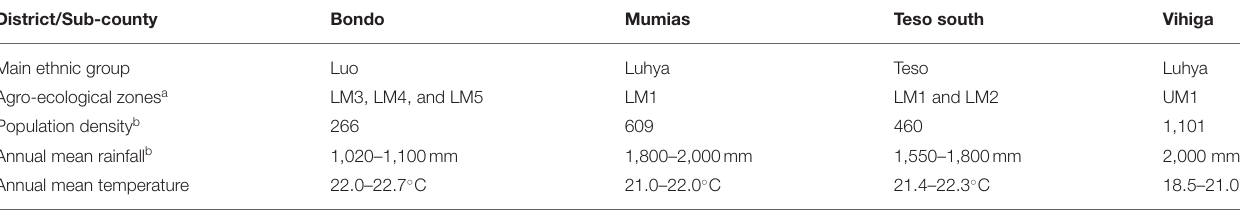
TABLE 1 | Characteristics of the study areas in Western